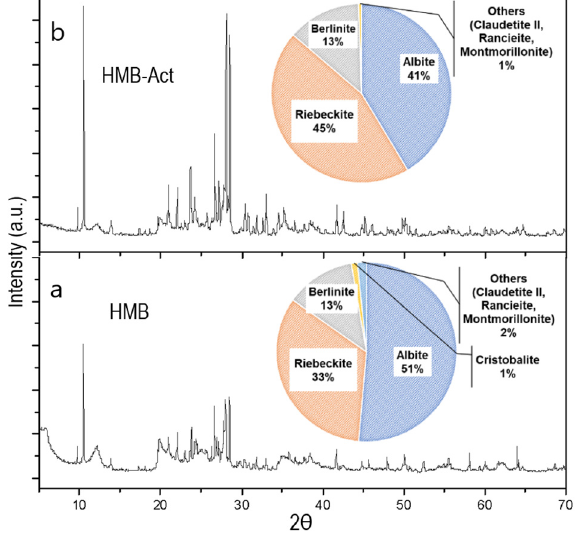
Figure 1. X-ray diffractogram of clay; ( a ) natural clay HMB, ( b ) active clay HMB-Act.